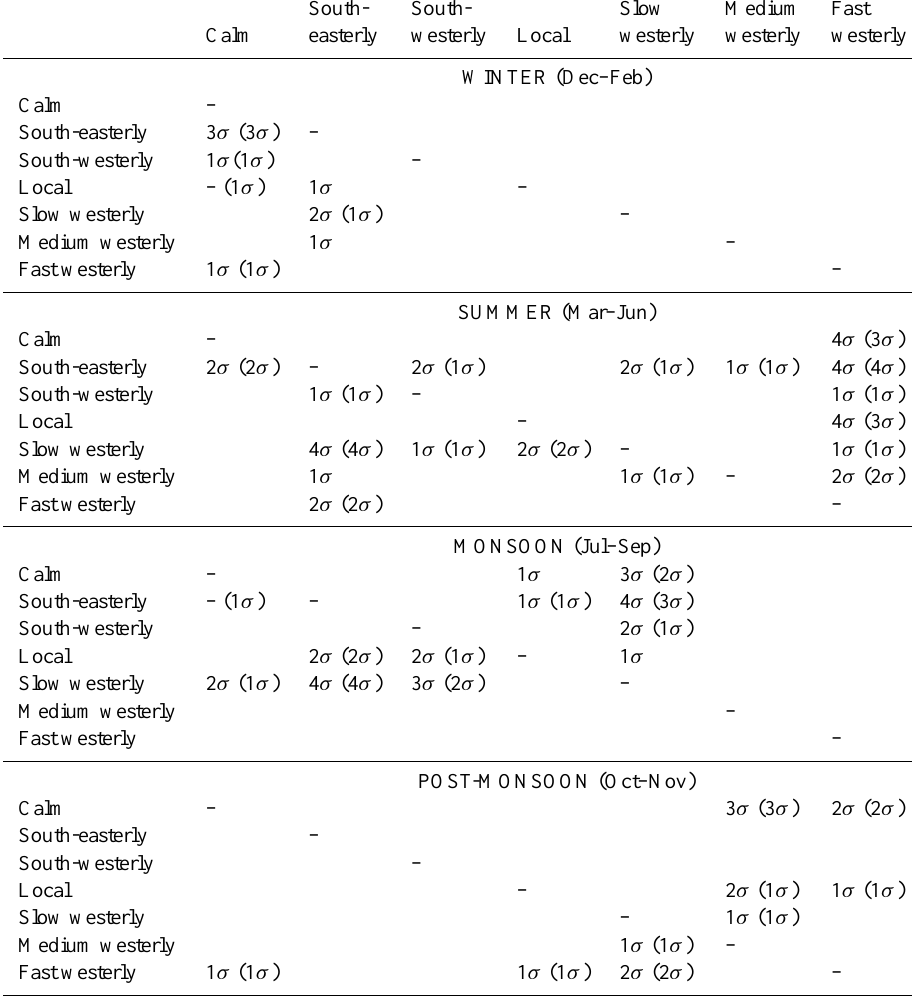
Table 3. Statistical significance of the difference of the mean for each pair of clusters. Values to the right of the principal diagonal denote significance among PM 10–2 . 5 pairs while values to the left of the principal diagonal denote significance among PM 2 . 5 pairs. Pairwise comparison based on Tukey’s studentised HSD (honestly significant differences) test was used to assess the statistical significance of the difference of the mean for each pair of clusters and each season. Values in brackets indicate the statistical significance after all rain events were removed from the data